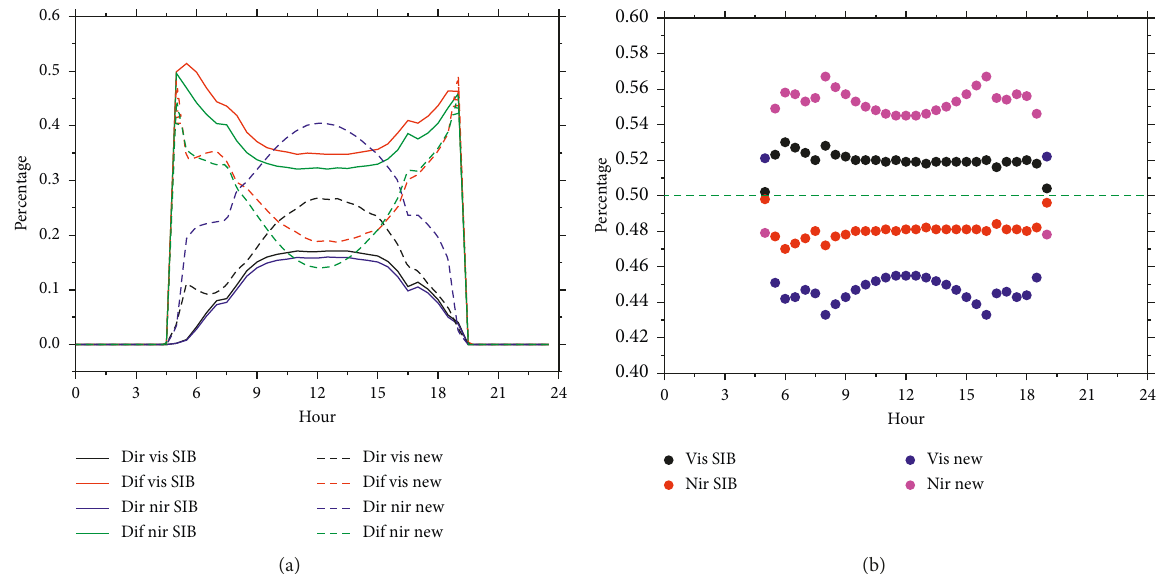
Figure 4: Comparison of the annual averaged diurnal cycle of the solar radiation partitioning between the method based on the SiB3 and the new surface albedo parameterization schemes. (a) Direct visible radiation, diffuse visible radiation, direct near-infrared radiation, and diffuse near-infrared radiation. (b) Total visible and near-infrared radiation.